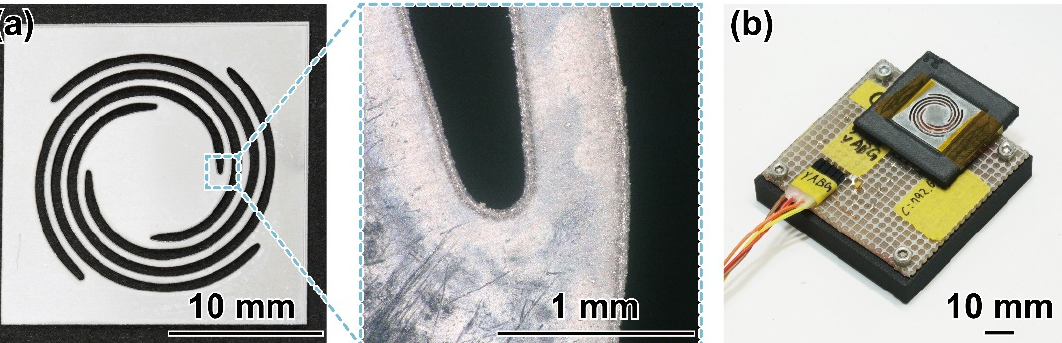
Figure 5. Photographs of ( a ) the fabricated planar spring by a fiber laser cutting machine and ( b ) the assembled force plate.